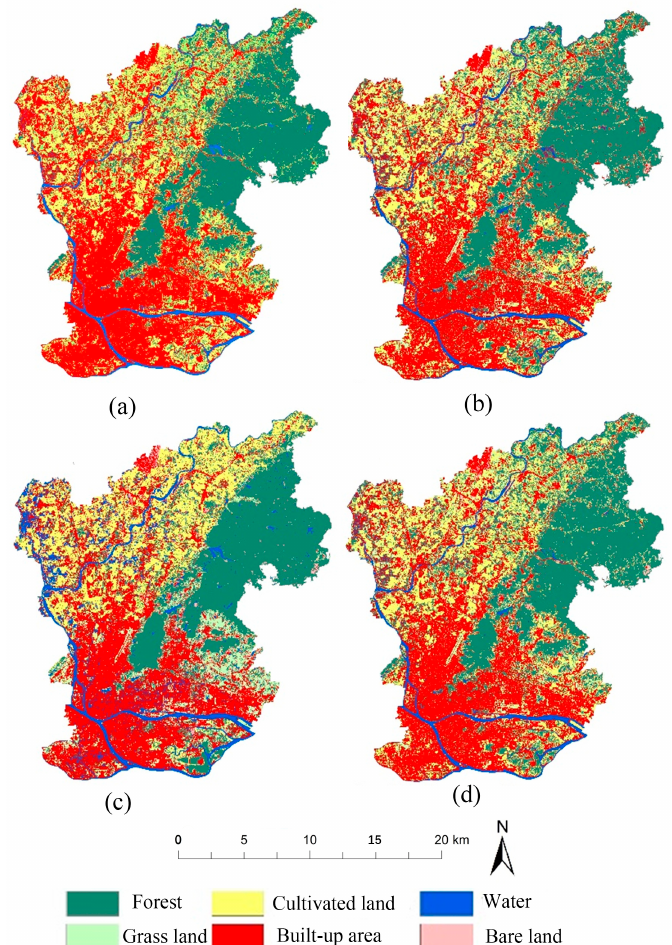
Figure 5. Land use/cover maps for the Guangzhou metropolitan area in 2001 produced using different classifiers: ( a ) SVM; ( b ) C4.5; ( c ) ANN; and ( d ) MCS_WV AdaBoost (MCS_WV improved by AdaBoost).